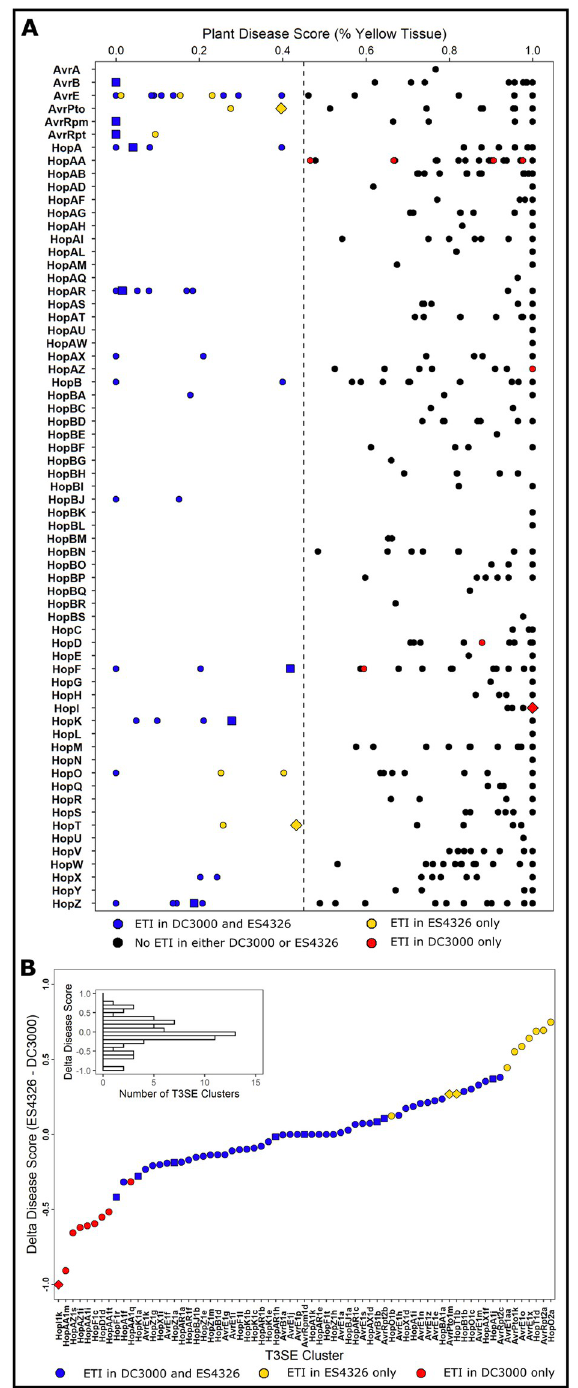
Fig 1. ETI potential of P . syringae T3SEs delivered from PmaES4326. (A) Plant disease scores of PmaES4326 strains carrying each of the 529 PsyTEC T3SE alleles from 65 families after spray infection of 4–6 A . thaliana accession Col-0 individuals. Plant disease scores were determined by assessing the percent of yellow tissue [43] within the bounds of the positive ETI control (HopZ1a, disease score = 0.0) and the negative ETI control (EV, disease score = 1.0). A disease score below 0.45 was used as the threshold to classify ETI responses. Color coding provides a comparison of the current PmaES4326 data to published PtoDC3000 data [9]: black—no ETI when delivered from either genetic background; blue—ETI when delivered from either PtoDC3000 or PmaES4326; red—ETI observed only when delivered from PtoDC3000; and yellow—ETI observed only when delivered from PmaES4326. The eight